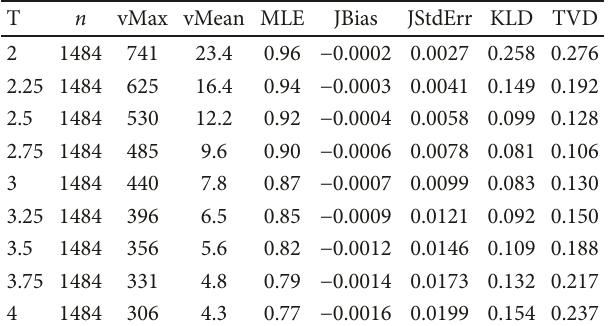
Table 1: Results with P = 1 (zeros merged with ones).